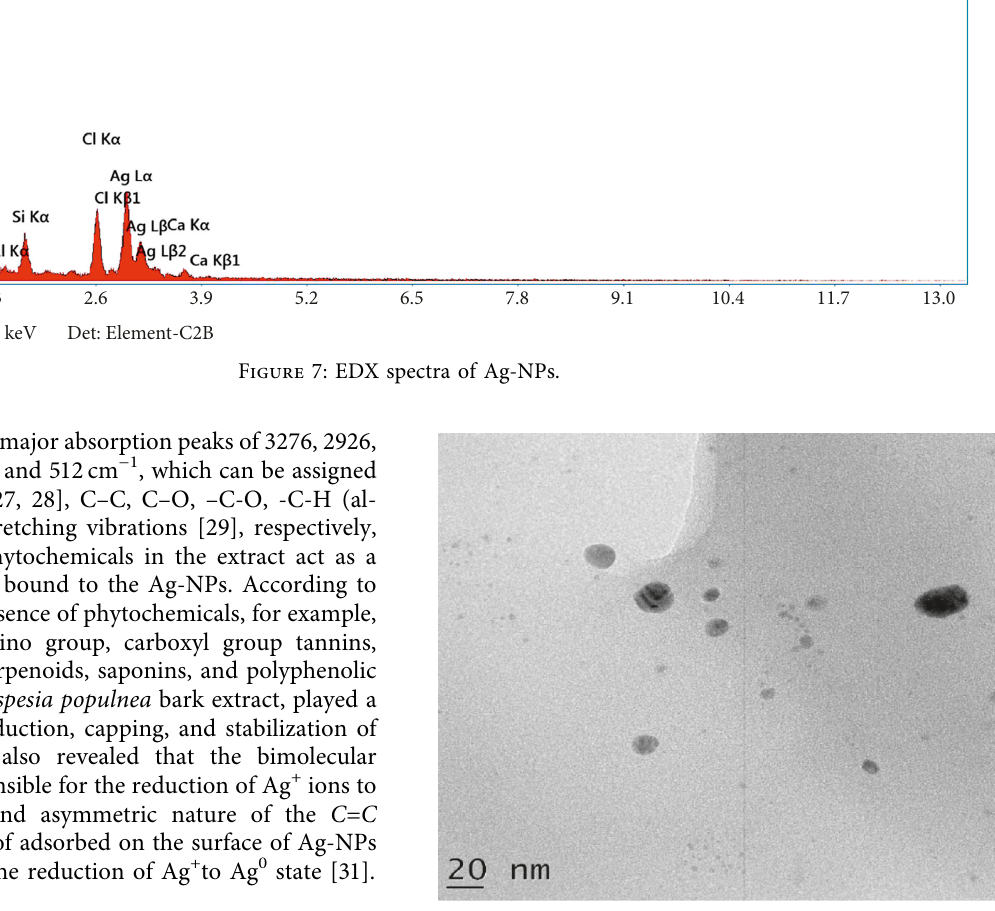
Figure 8: TEM image of